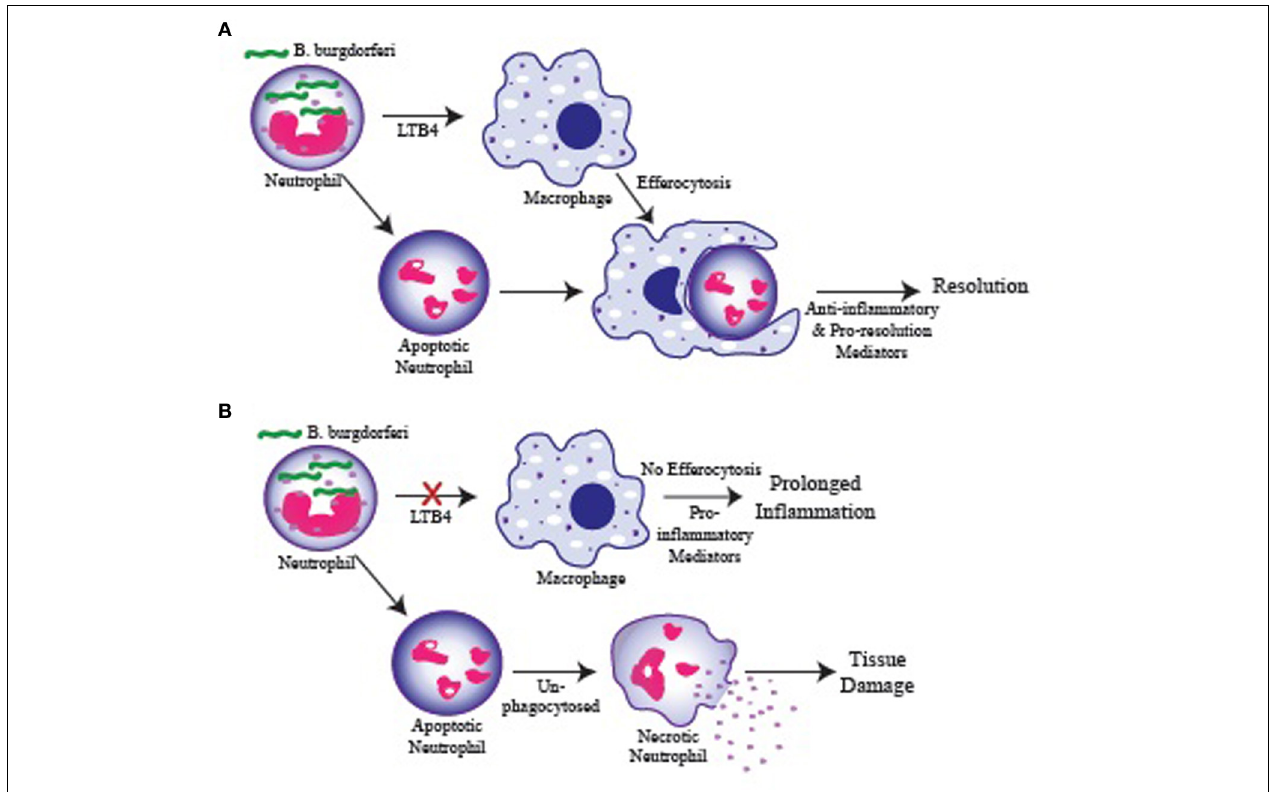
in inefficient macrophage phagocytosis and failure to clear apoptotic neutrophils in a timely manner. Apoptotic neutrophils in the tissue proceed to necrosis and release their cytoplasmic contents causing tissue damage and promoting continued inflammation. Similarly, macrophages that fail to engulf apoptotic cells remain in a pro-inflammatory state and promote prolonged